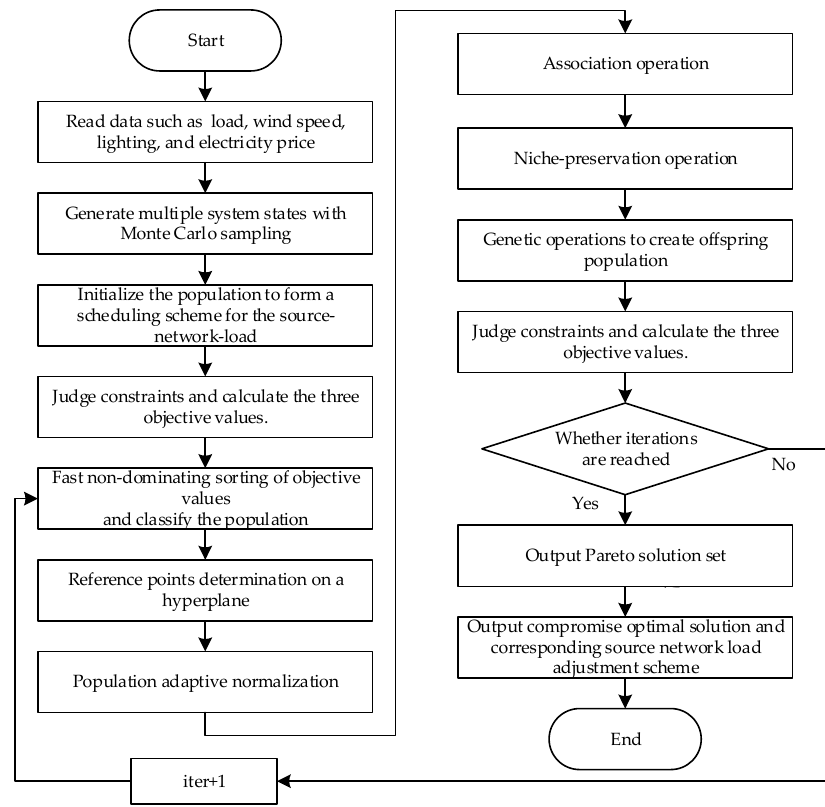
Figure 6. Flowchart of multiobjective optimal scheduling of the active distribution network (ADN).